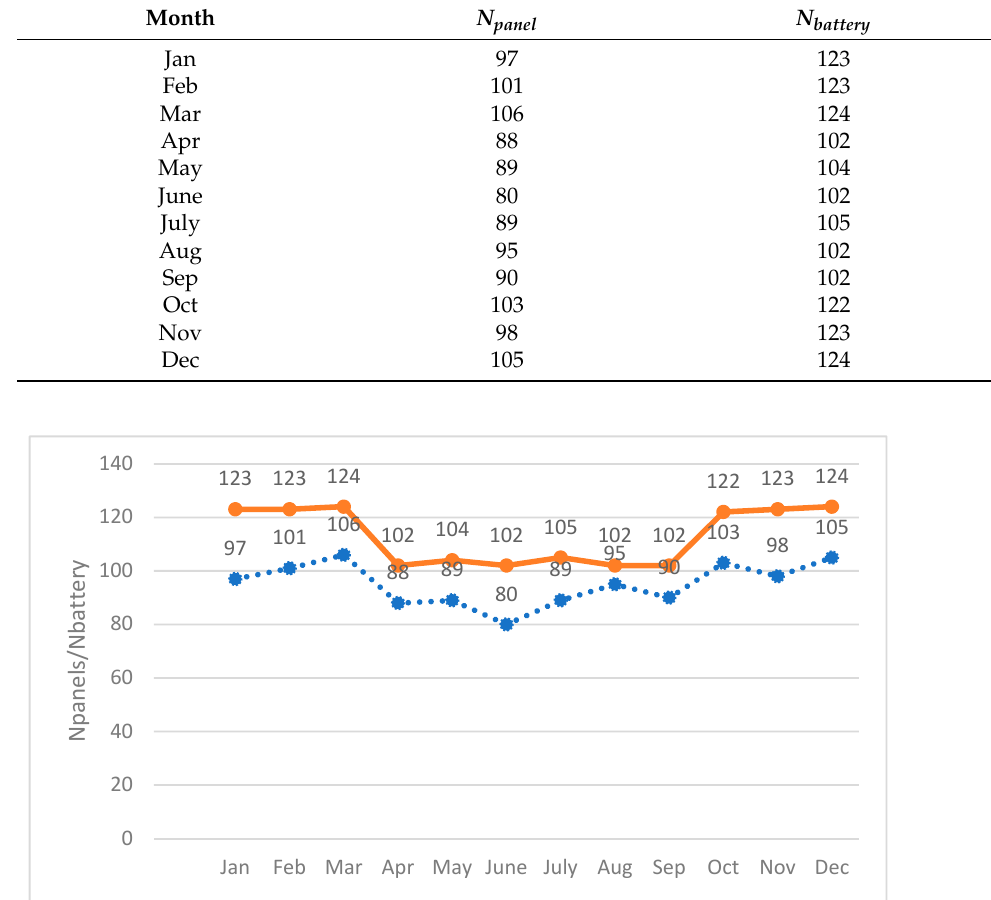
Table 10. Optimized values for number of panels and batteries.